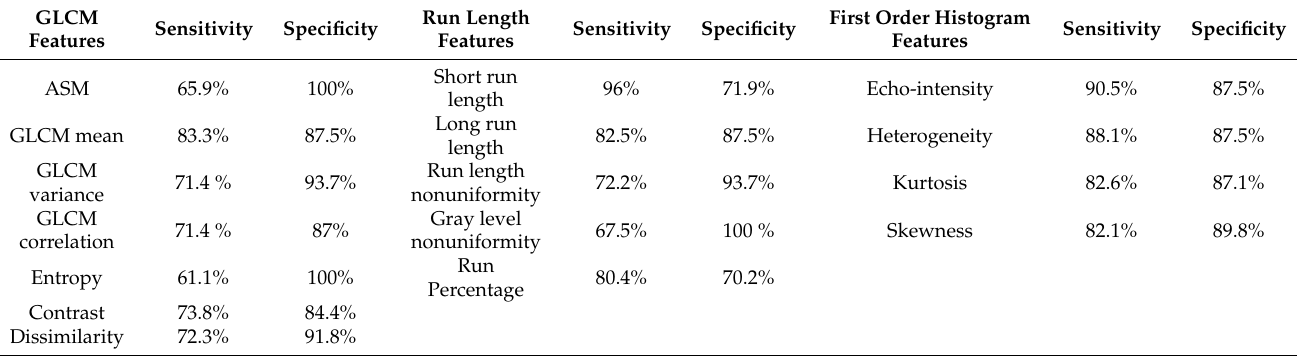
Table 2. The diagnostic performance of the ultrasound texture features in detecting early and advanced liver